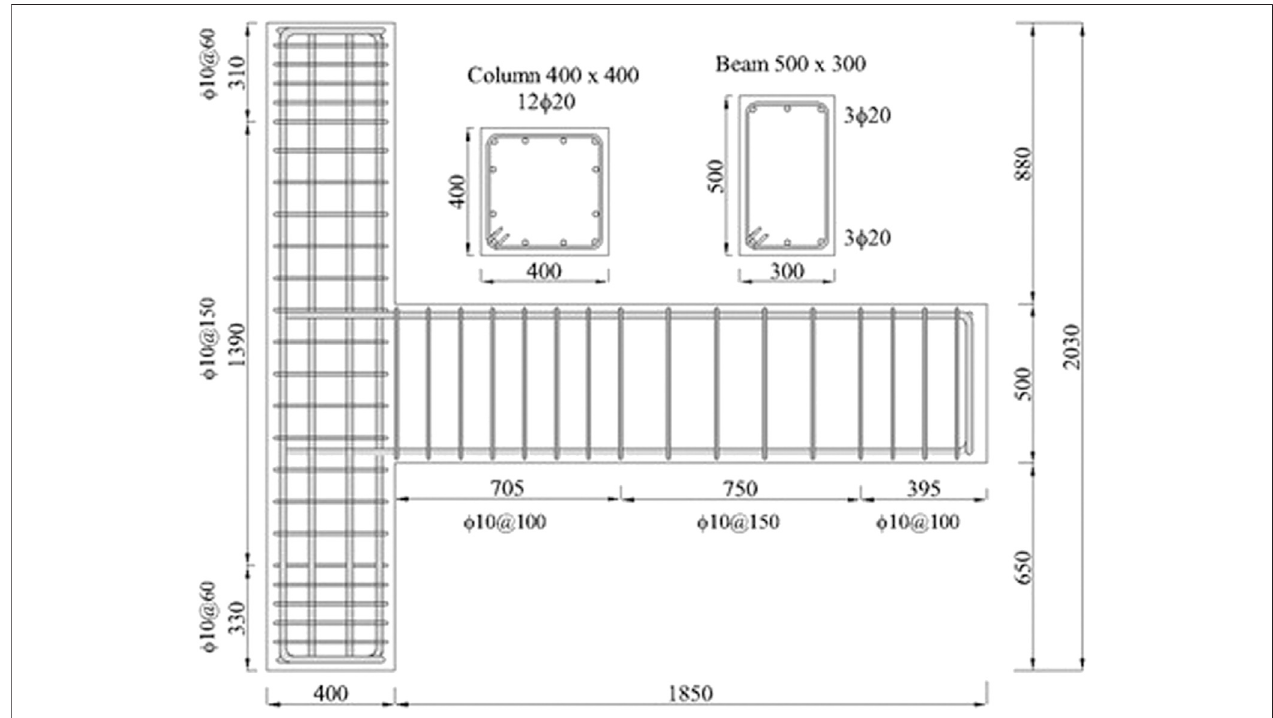
FIGURE 2 | Reinforcement detail of monolithic test specimen (dimensions in mm).